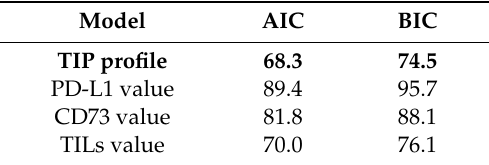
Table 6. Akaike information criterion (AIC) and Bayesian information criterion (BIC) values of compared